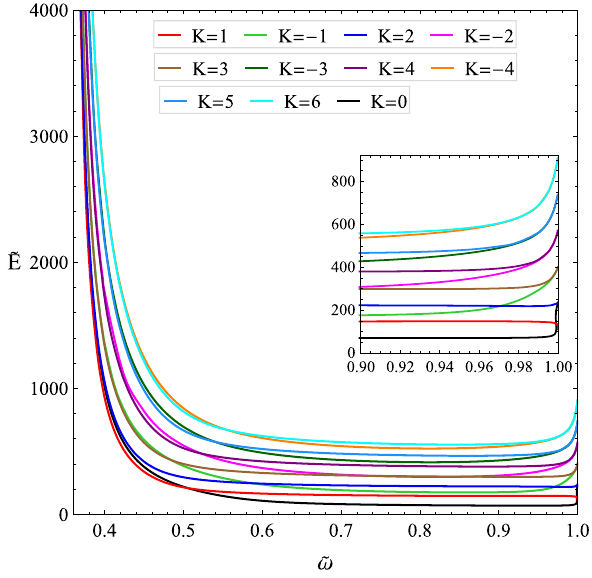
Fig. 11 Dependence of the energy ˜ E of the vortex-Q-ball system on the phase frequency ˜ ω for the first few azimuthally excited states. The curves correspond to parameters ˜ m = 1, ˜ g = 1, ˜ h = 0 . 2, ˜ λ = 0 . 125, ˜ v = 2, ˜ e = ˜ q = 0 . 1, and N =